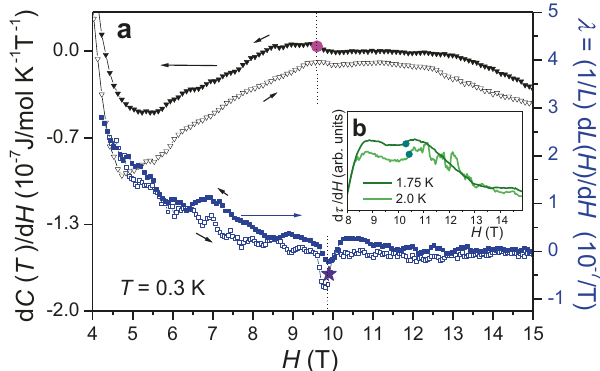
Fig. 4 Thermodynamic bulk probes displaying the phase transition between the BCS low- fi eld SC phase and the FLLO state in NbS 2 . a Magnetic fi eld derivative d C ( T )/d H of the speci fi c heat, measured at 300 mK during a fi eld sweep (see Fig. 4 b for the corresponding C / T data) together with the linear magnetostriction coef fi cient λ ¼ ð 1 = L Þ d L ð H Þ = d H for magnetic fi elds applied strictly parallel to the layer structure. Both quantities reproducibly show a small transition anomaly at ~10 T, as marked by the circle and star symbols to be included in the phase diagram in Fig. 5. b Field derivative d τ ( H )/d H of the magnetic torque for selected temperatures showing a small step-like anomaly near 10 T, as marked by the exceeds our highest fi eld of 15 T, and a hysteresis exists up to 15 T (Fig. 2b).